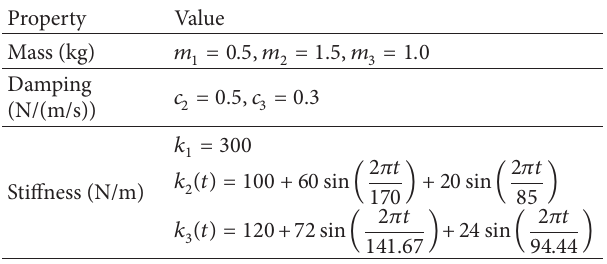
Figure 1: A time-varying structural system. Table 1: Time-varying system